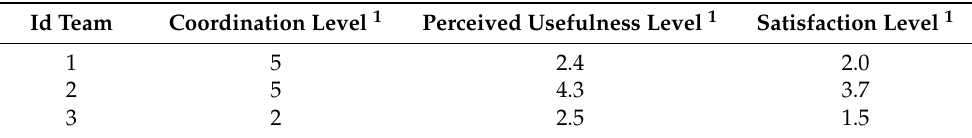
Table 4. Perception of the groups and average